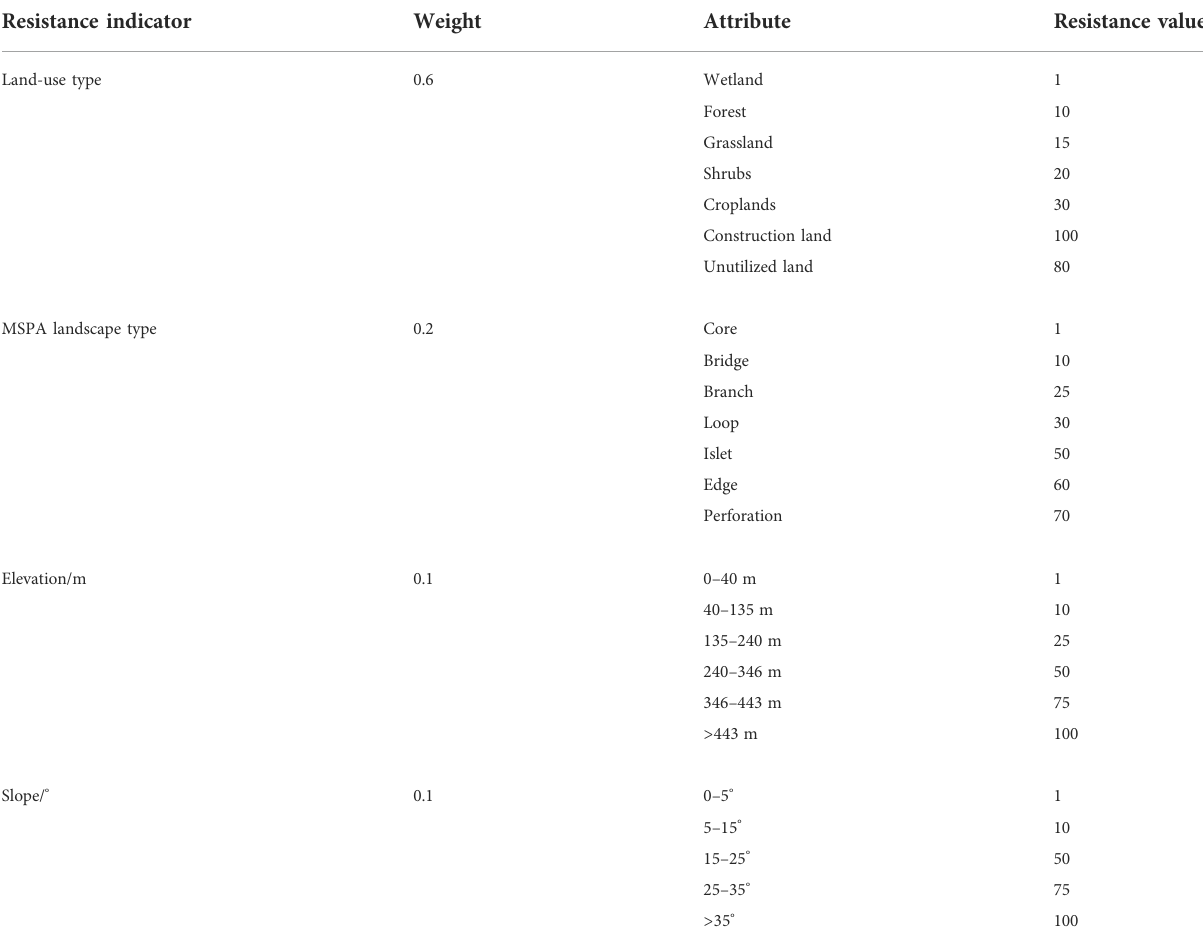
TABLE 4 Resistance value criteria for each resistance